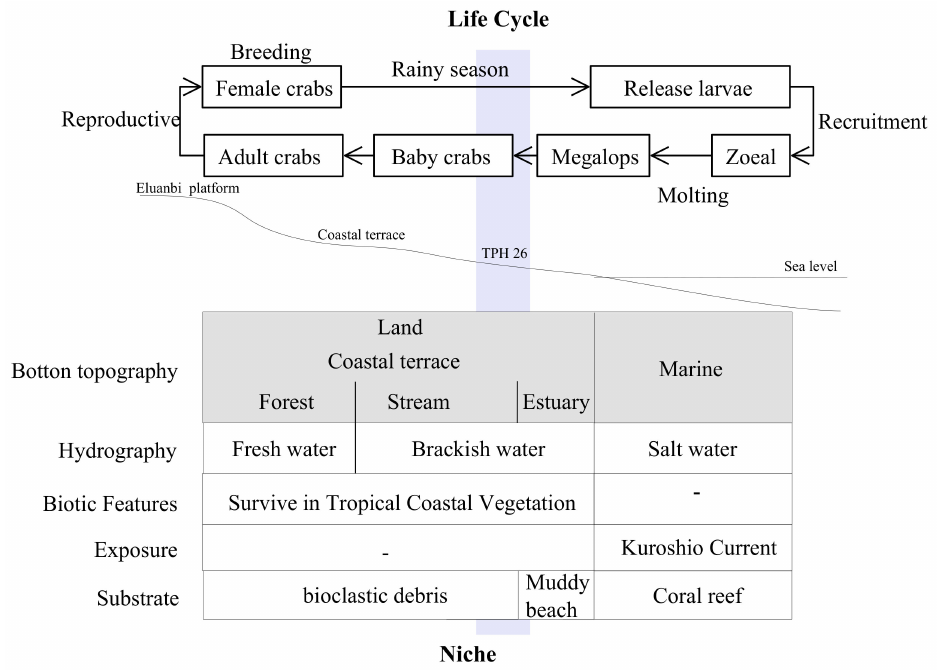
Figure 8. The life cycle and niche of land crabs in Banana